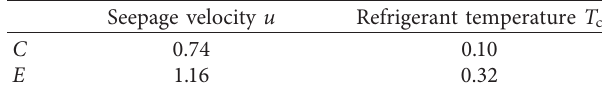
Figure 11: Curves of the effect of various factors on k . (a) Seepage velocity u vs. k . (b) Refrigerant temperature T Table 5: Calculation of variance of C and E. Seepage velocity